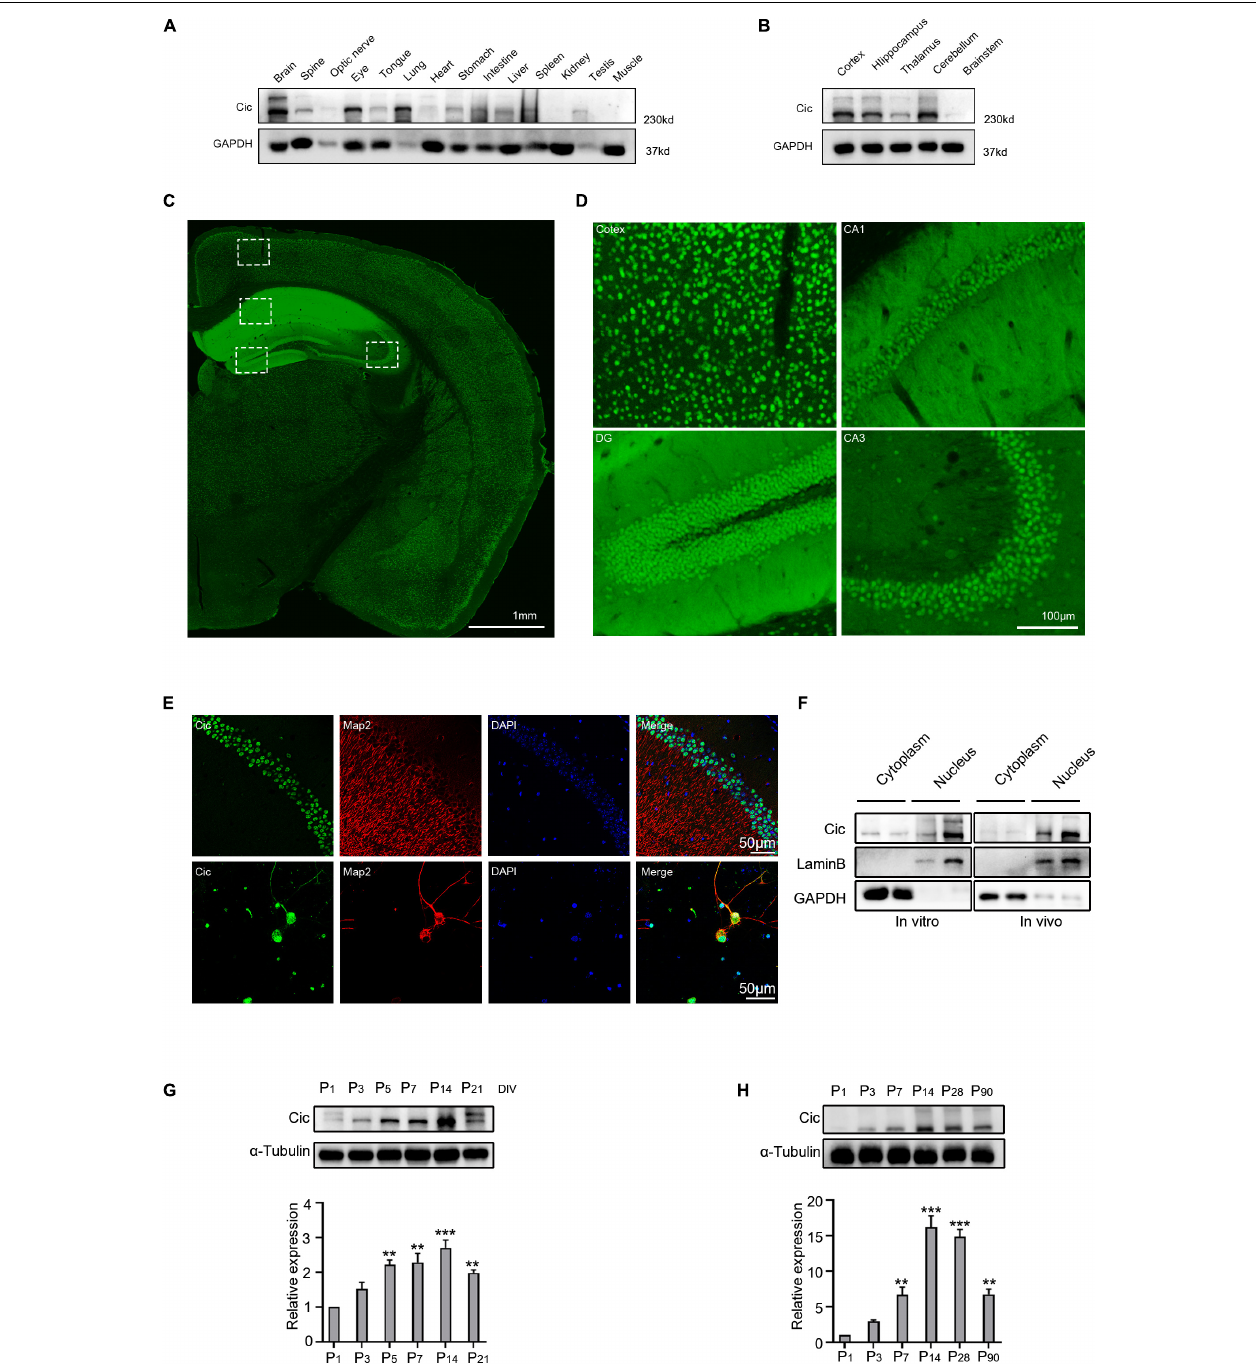
FIGURE 1 | Detection of Cic expression in hippocampal neurons. (A,B) The expression of Cic in different tissues and different regions of the brain was analyzed by western blot. (C) The expression of Cic in the brain was analyzed by immunofluorescence. (D) Higher magnification view of the boxes in (C) . (E) Expression of Cic (green) with the neuron dendritic marker Map2 (red), as shown by immunofluorescence in brain slices and cultured hippocampal neurons after DIV 14. Nuclear staining with DAPI is also shown. The last panel shows merged images. (F) The nuclear and cytoplasmic expression of Cic in cultured hippocampal neurons at DIV 14 ( in vitro ) and in the hippocampus ( in vivo ) was detected by western blot. (G) Hippocampal culture lysates from DIV 1 to 21 were immunoblotted to detect Cic, and α -tubulin was used as a loading control. The bottom panel shows the quantification of Cic levels in western blots as in (G) , normalized to α -tubulin; n = 3 independent hippocampal cultures. ** p < 0.01, *** p < 0.001 versus the P1 group. (H) Mouse hippocampal homogenates obtained at the indicated stages were immunoblotted to detect Cic, and α -tubulin was used as a loading control. The lower panel shows the quantification of Cic levels in western blots as in (H) , normalized to α -tubulin; n = 3 independent homogenates. ** P < 0.01, *** p < 0.001 versus the P1 group.